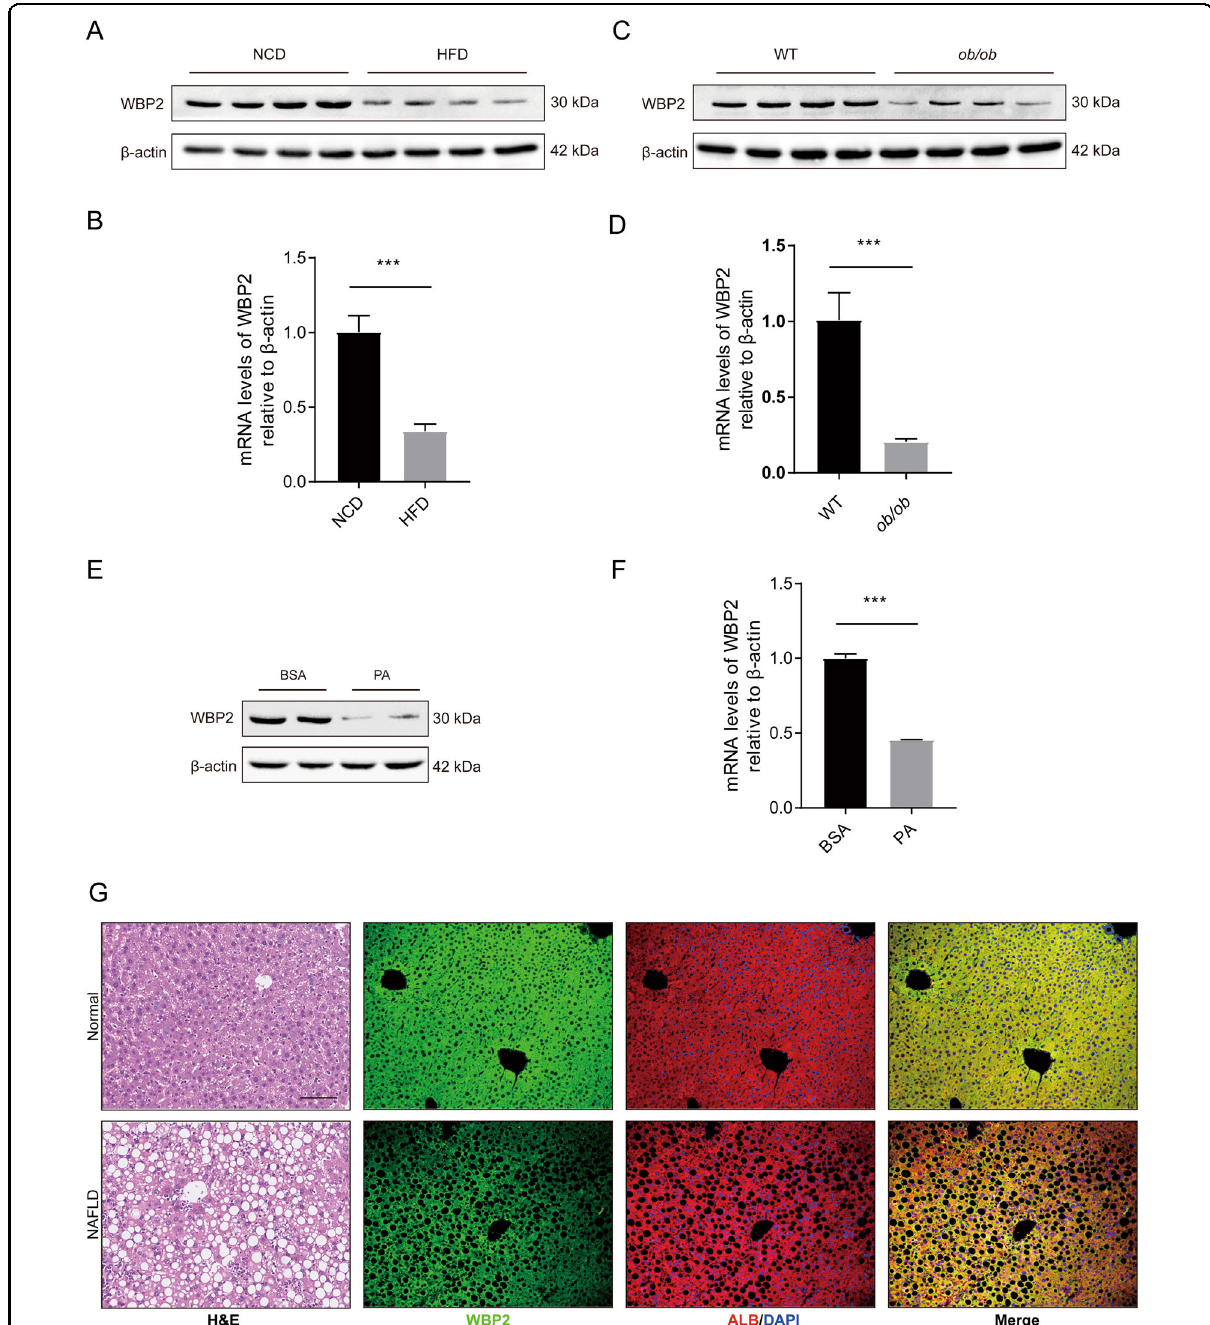
Fig. 1 WBP2 is downregulated in livers with hepatic steatosis. A , B The representative protein ( A ) and mRNA ( B ) levels of WBP2 in the livers of the mice subjected to an HFD and an NCD for 16 weeks ( n = 8/group). C , D Representative protein ( C ) and mRNA ( D ) levels of WBP2 in the livers of the WT or ob/ob mice ( n = 8/group). E , F The primary hepatocytes isolated from the livers of wild-type mice was stimulated with PA (0.25 mM) for 24 h, and WBP2 expression was examined by western blots ( E ) and RT-PCR ( F ) ( n = 3 independent experiments). The protein and mRNA expression levels were normalized to the β -actin levels. G Representative images of H&E staining and immuno fl uorescence staining for WBP2 (green), ALB (red) and DAPI (blue) in the liver samples from mice fed an HFD or an NCD for 16 weeks ( n = 8/group). Scale bar, 100 μ m. Data are expressed as the mean ± SEM, *** P <